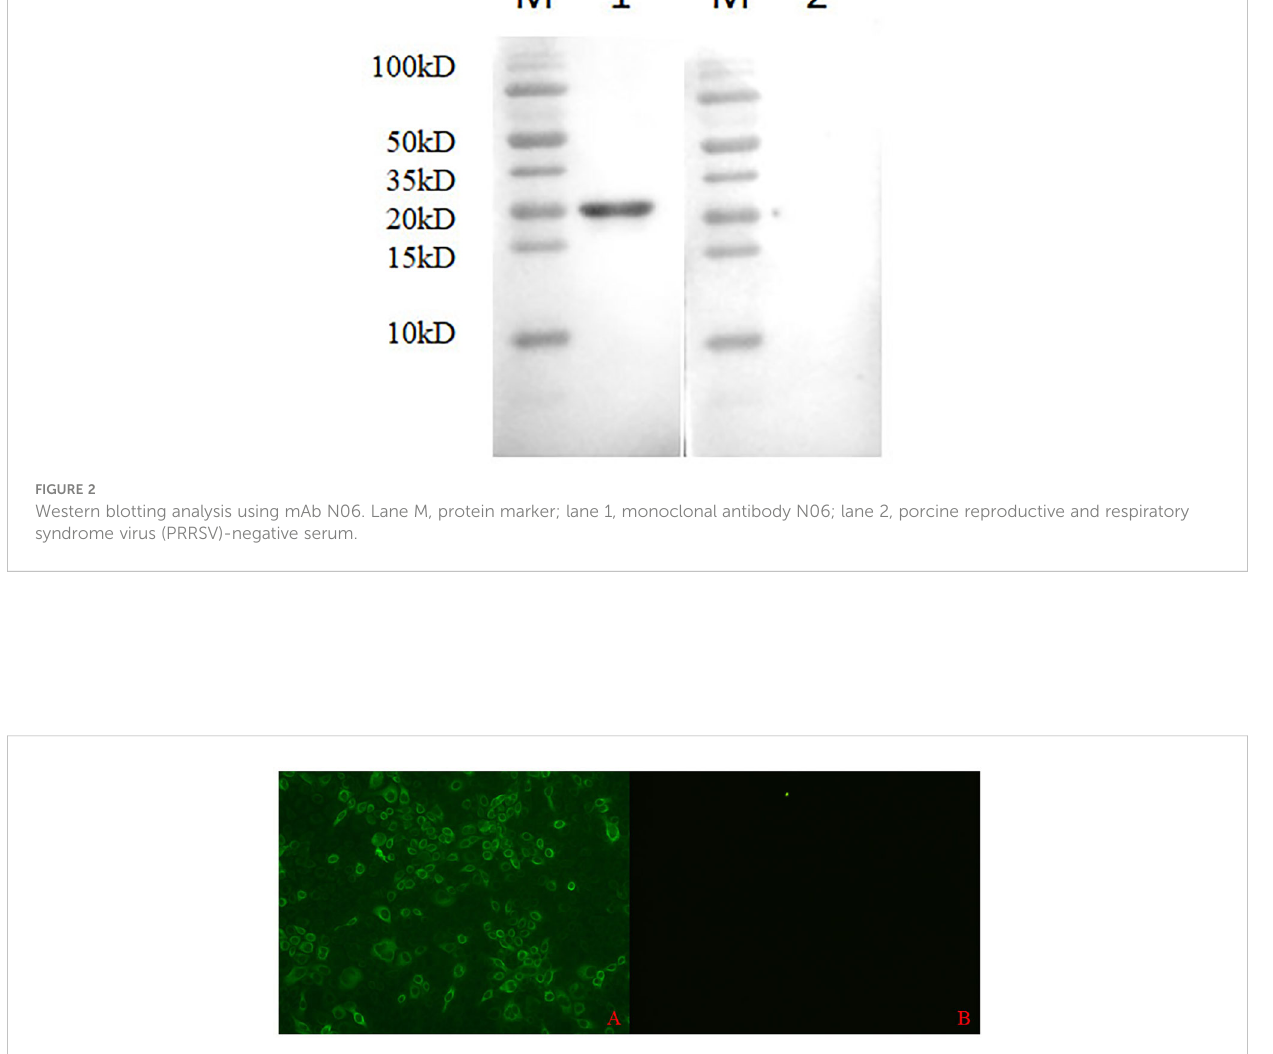
FIGURE 3 Immuno fl uorescence assay analysis of monoclonal antibody (mAb) N06 with the native porcine reproductive and respiratory syndrome virus (PRRSV) antigen. (A) ; mAb N06 reacted with PRRSV-infected cells, (B) ; PRRSV-negative serum applied as negative